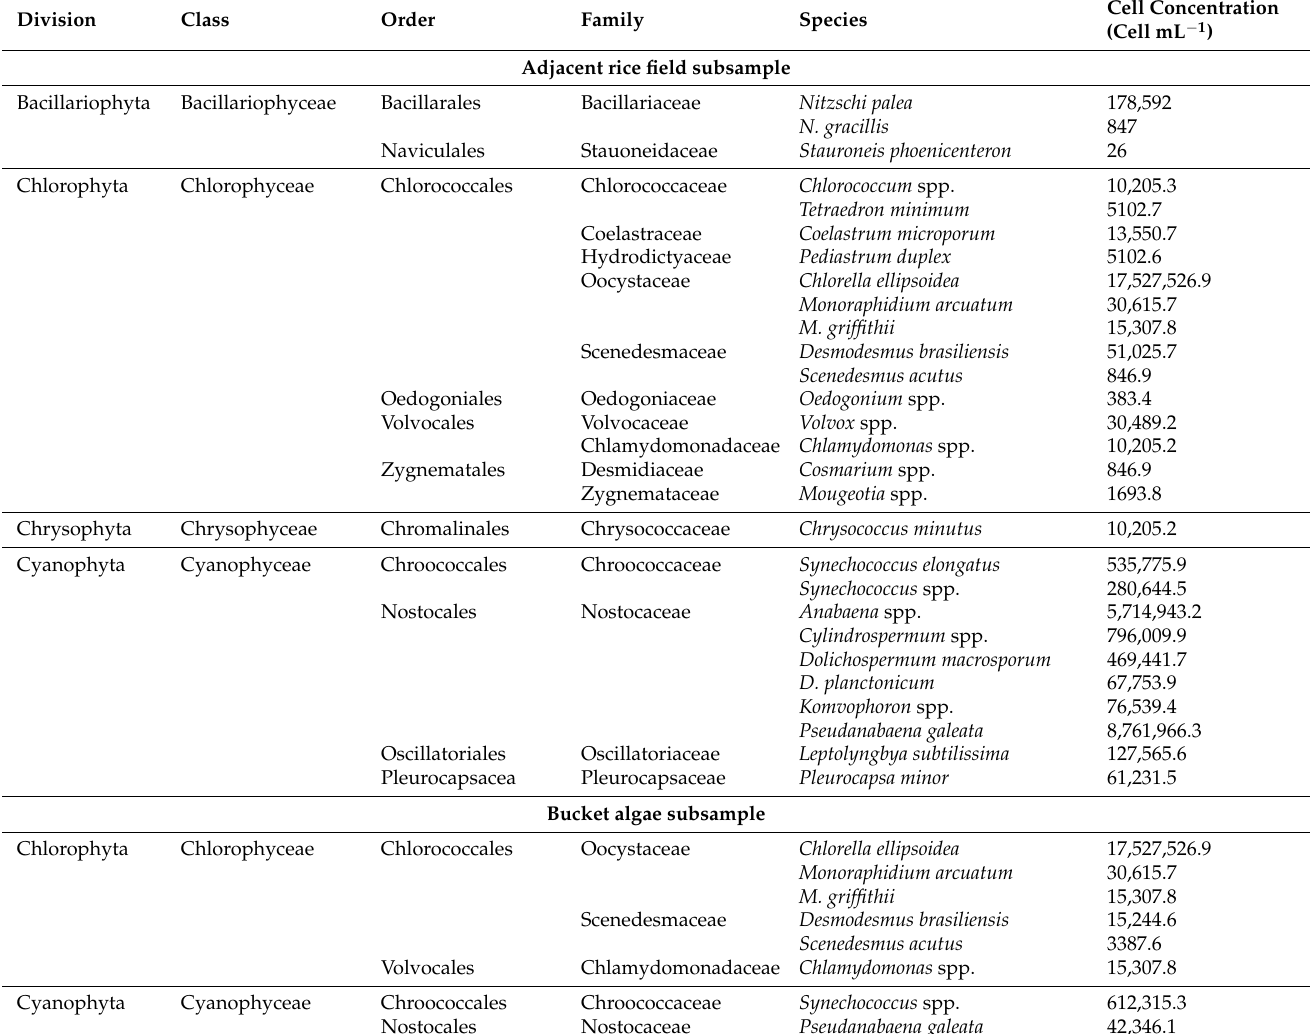
Table 4. List of algae and Cyanobacteria genus/species identified in the rice field and nutrient study